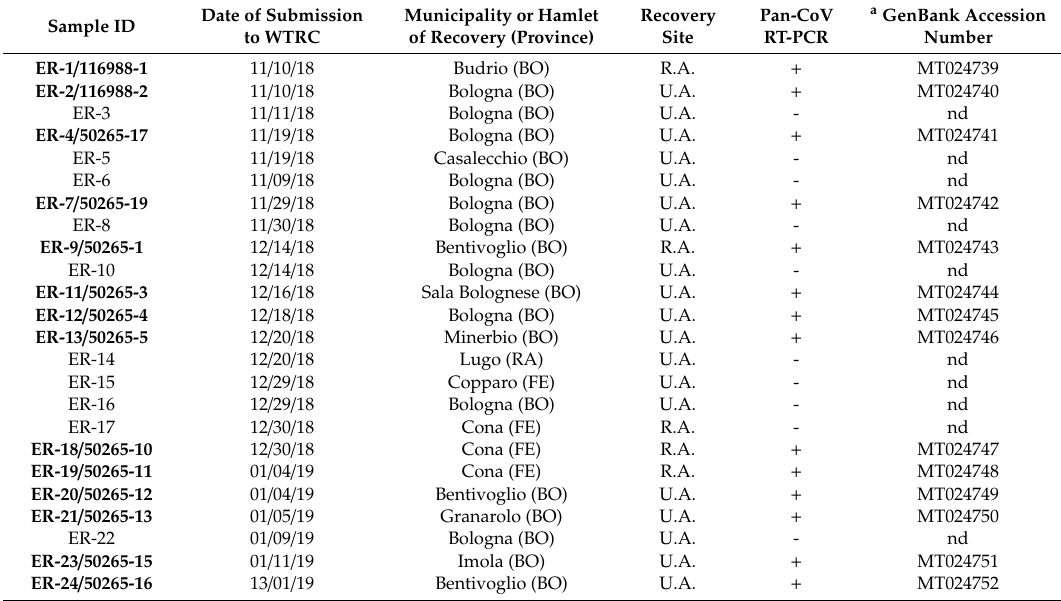
Table 1. Detection of Erinaceus coronaviruses (EriCoVs) in Western European hedgehogs ( Erinaceus europaeus ) from rural and urban areas of Northern